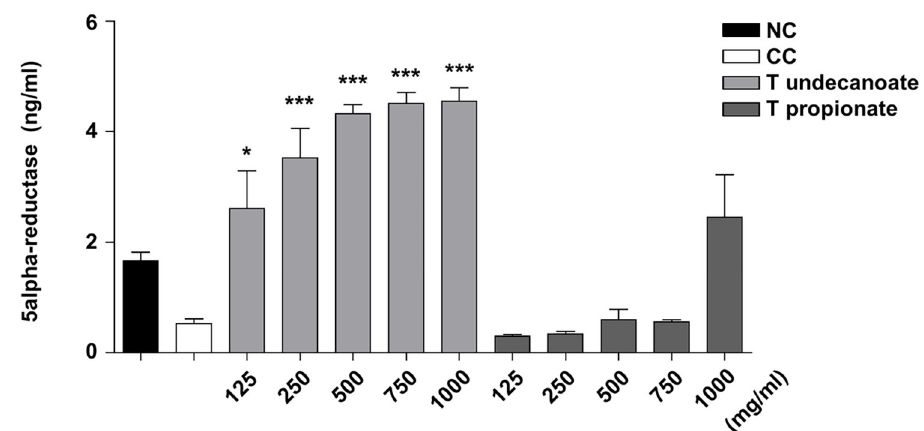
Fig 2. The serum level of 5-alpha reductase. The serum level of 5-alpha reductase after injecting testosterone undecanoate (T undecanoate) or testosterone propionate (T propionate). Treatment groups were injected T undecanoate or T propionate (125, 250, 500, 750, or 1000 mg/kg b.wt) after castration. Both control groups and 1000mg/kg b.wt group consisted of 5 rats, other group consisted of 6 rats at the beginning of the experiment. Values are expressed as the mean ± SD. � p < 0.05, �� p < 0.01, ��� p < 0.001 compared with normal control (NC). Statistical analysis was performed by ANOVA and Tukey-Kramer multiple comparison